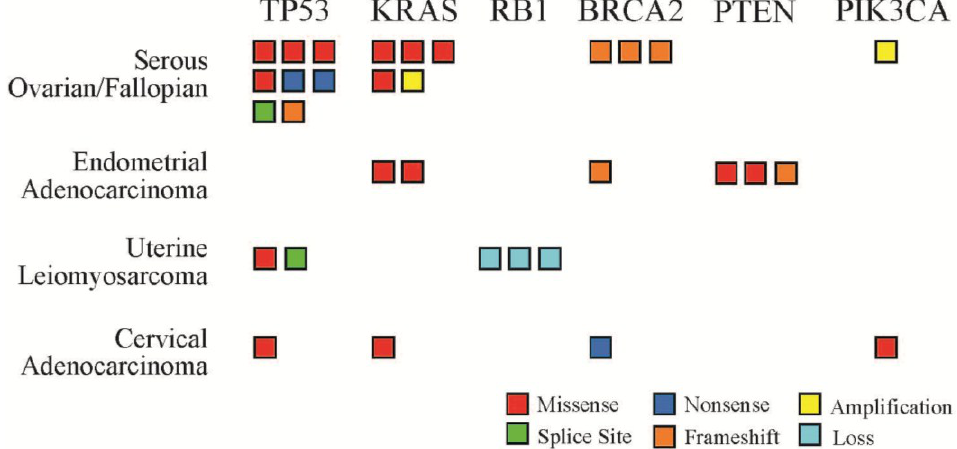
Figure 1. Number and type of genetic alterations identified by tumor profiling. Six genes were mutated in multiple patient samples across the four most common tumor types in this series. Each box represents one patient sample. Mutation types include missense (red), splice site (green), nonsense (dark blue), frame shift (orange), amplification (yellow), and gene loss (light